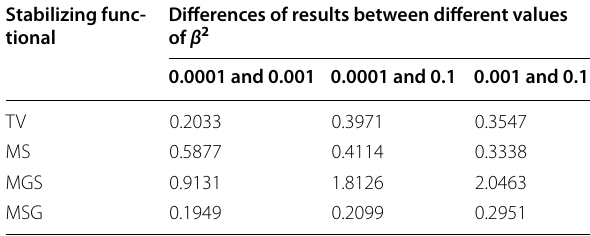
Table 6 Differences (calculated using Eq. (18)) between the inversion results of model B (Fig. 2b) obtained using different values of β 2 Stabilizing func‑ Differences of results between different values tional of β 2